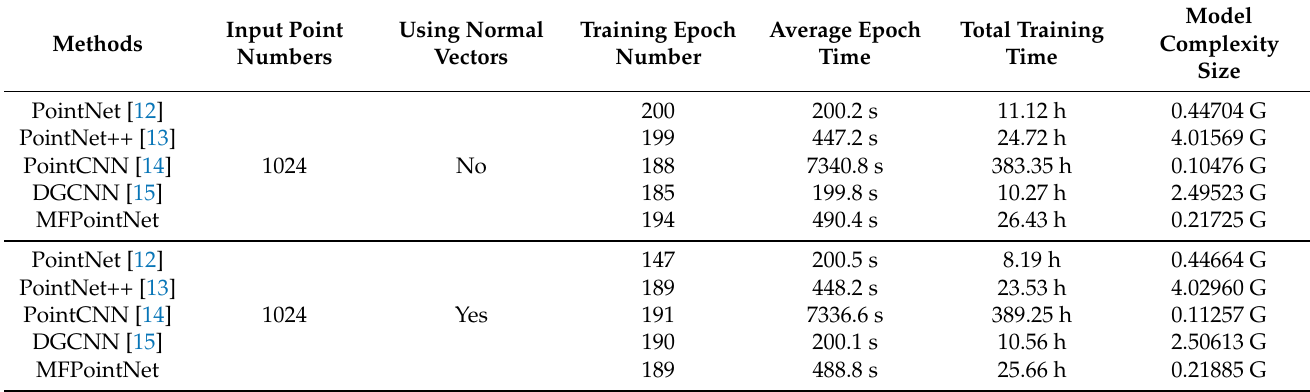
Table 6. The effect of normal vectors on training time and model complexity